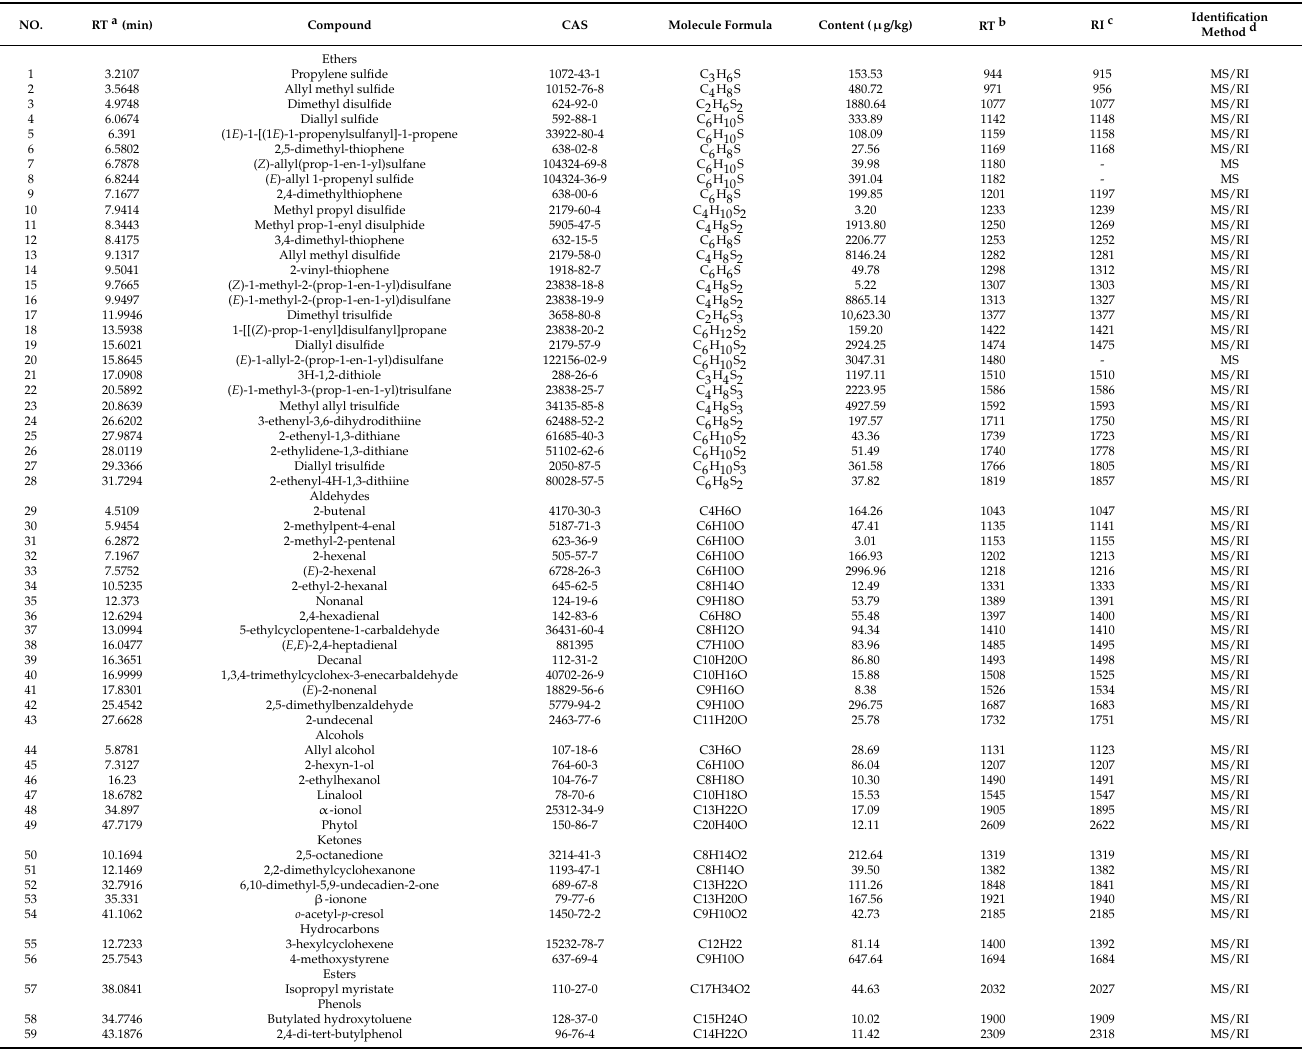
Table 1. The composition and content of volatile compounds in Chinese